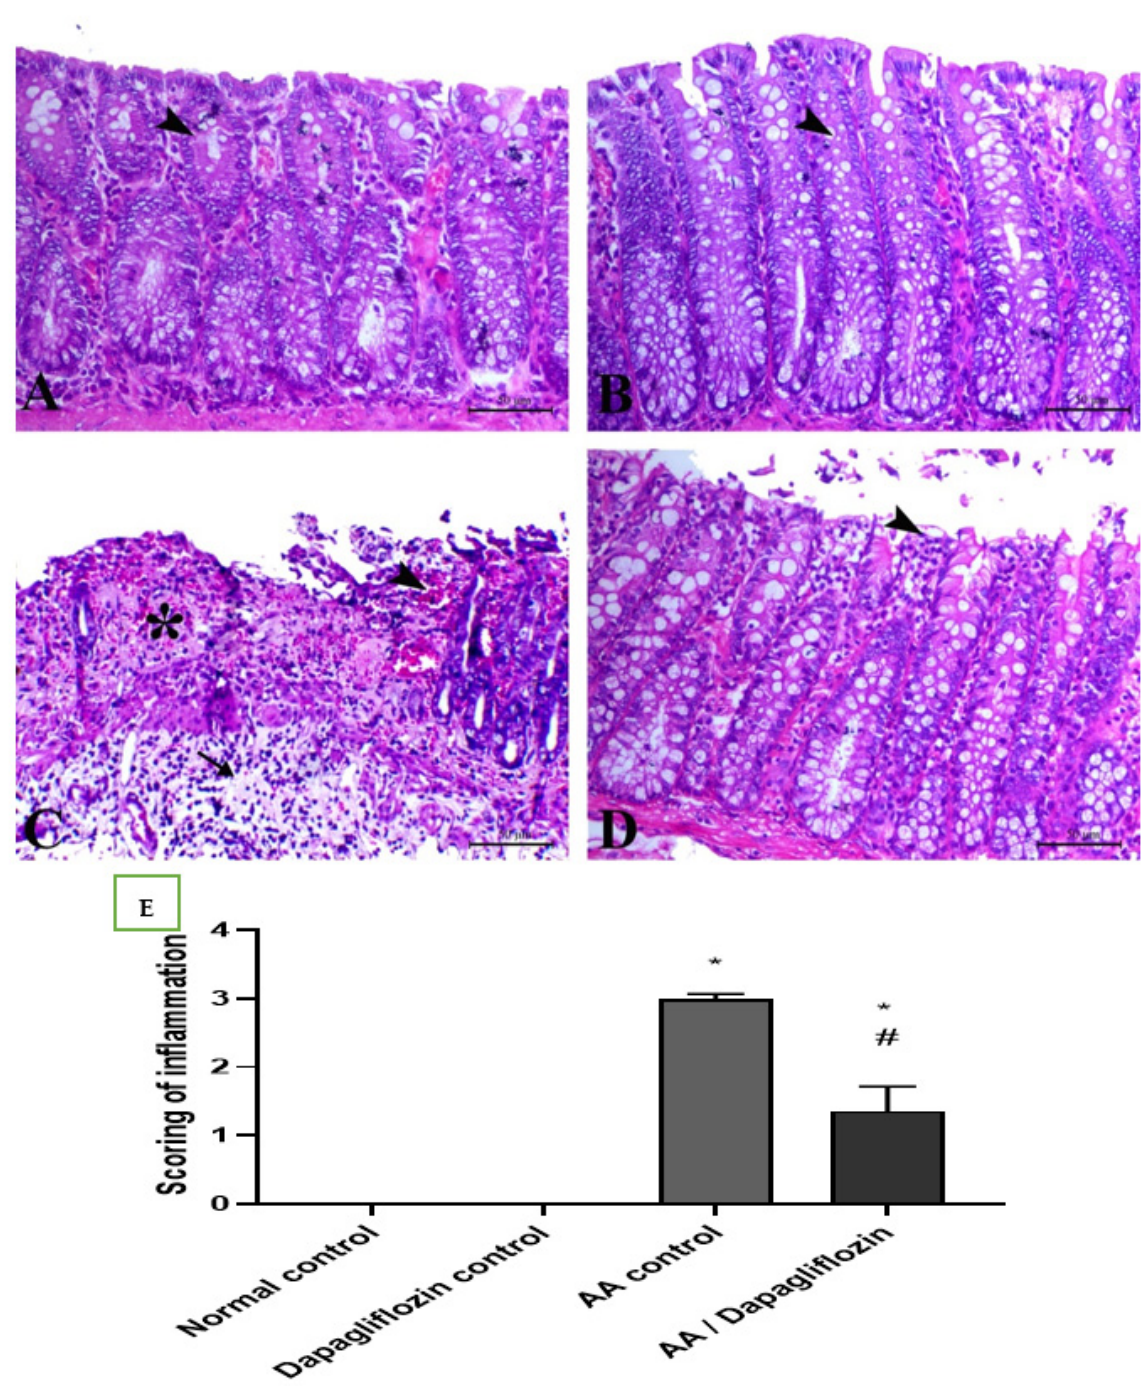
Figure 6. ( A ) Colonic sections stained by H&E showing the effect of DAPA for 14 days on AA-induced UC. Colonic sections from normal ( A ) and Dapagliflozin ( B ) control groups showing normal mucosa including surface epithelium and crypts (arrowheads). Colonic sections from the AA-induced colitis group ( C ) showing marked necrosis of the mucosal lining mixed with fibrin exudate and submucosal edema with marked inflammatory cells infiltration. Colonic sections from the Dapagliflozin-treated group ( D ) showing superficial mucosal necrosis (arrowhead). H&E, bar = 50 µ m. ( E ) Scoring of inflammation. Data are expressed as mean ± SEM. Superscript letters refer to the level of statistical significance which was calculated using one-way ANOVA followed by the Tukey–Kramer multiple comparisons test (* p < 0.05, DAPA compared to the normal control group; # p < 0.05, DAPA significantly different from the AA control